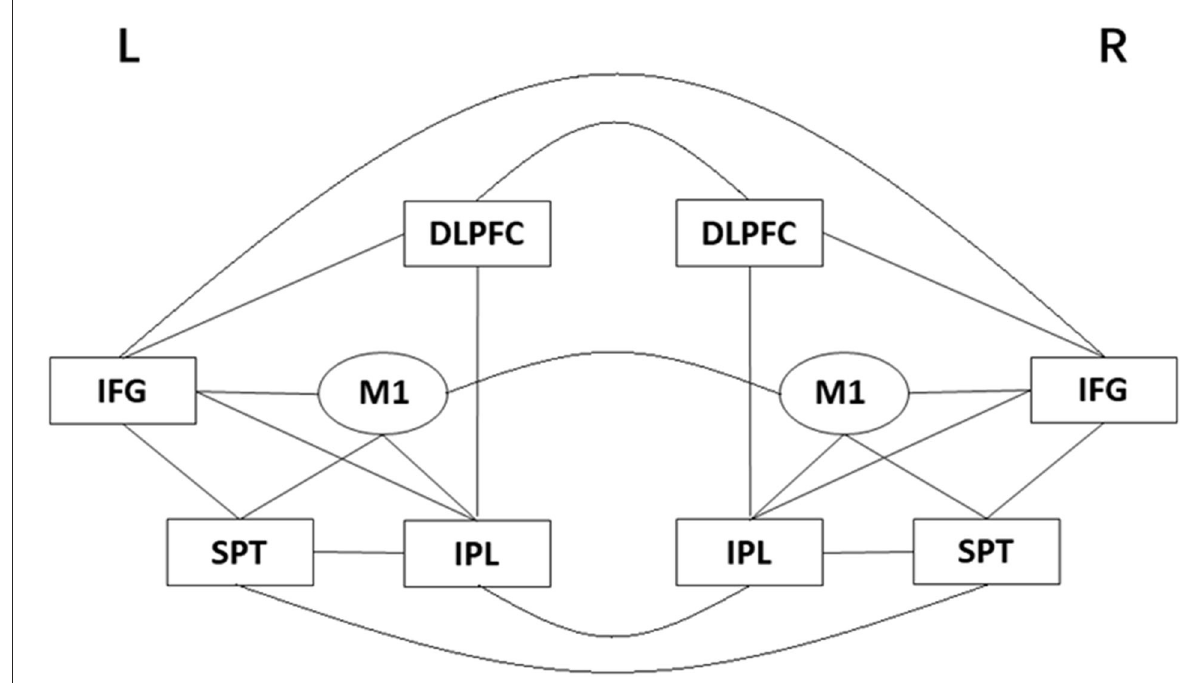
FIGURE1 A schematic diagram of the core speech articulation network of AOS. DLPFC, dorsolateral prefrontal cortex; IFG, inferior frontal gyrus; IPL, inferior parietal lobe; M1, primary motor cortex; SPT, Sylvian-parietal-temporal